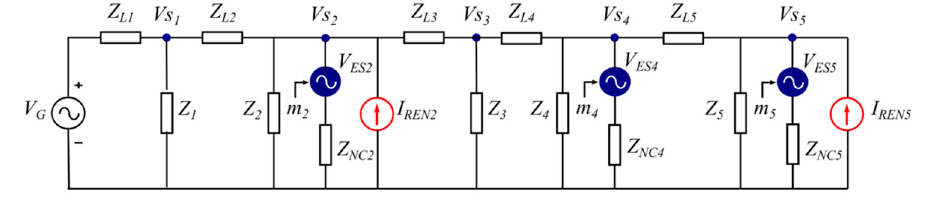
Figure 8. Single-phase radial µ G with distributed ESs and RES. Table 1. Parameters of the single-phase µ G.